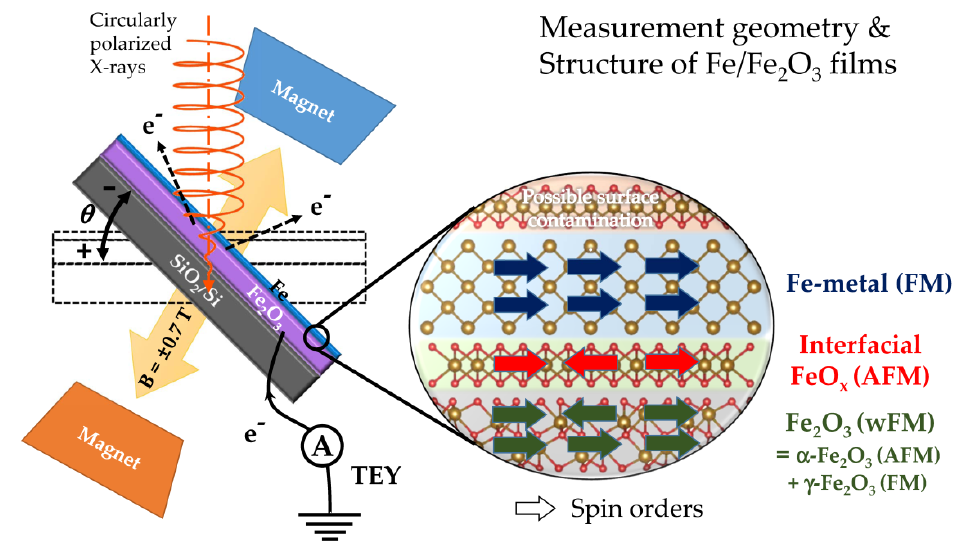
Figure 1. Schematics of the geometry of X-ray absorption spectroscopy (XAS) and X-ray magnetic circular dichroism (XMCD) measurements, and the atomic structures and magnetism of e-beam evaporated Fe / Fe 2 O 3 films according to the results of the analyses in this work.